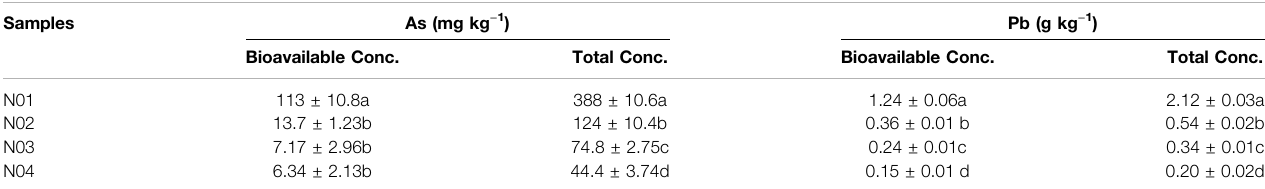
TABLE 2 | Total and bioavailability concentrations of As and Pb in soil samples collected from four sites. Different letters indicate signi fi cant differences among the different sites ( p < 0.05). Samples